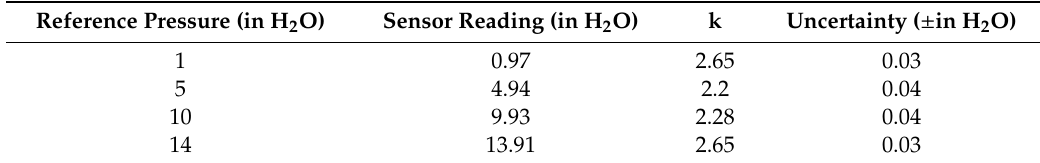
Table 6. Automated flowmeter calibration sheet at sea level pressure.